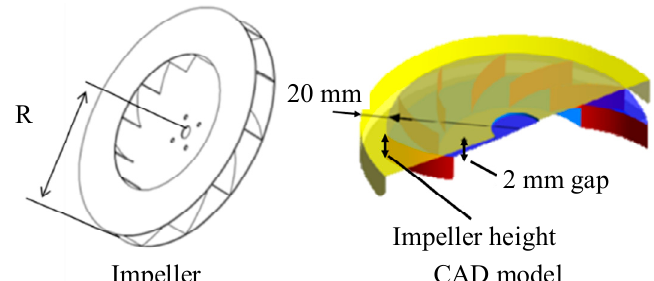
Figure 7. Impeller and CFD model.